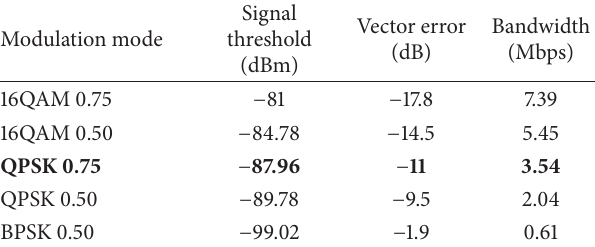
Table 2: PTP58500 adaptive system modulation.